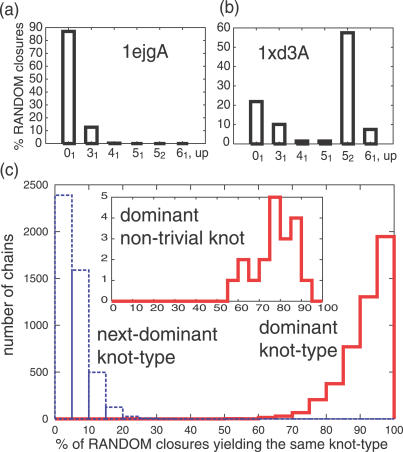
Dominance of Knot Types in the RANDOM Knot Closure(A) Percentage of the 1,000 RANDOM chain closures yielding the various knot types for the protein chain with ID 1ejgA and length N = 46. In this chain, the trivial knot or unknot (01) dominates, while the trefoil knot (31) is the next-dominant knot type. Both CENTER and DIRECT methods also predict a trivial knot.(B) Percentage of the 1,000 RANDOM chain closures yielding the various knot types for the protein chain with ID 1xd3A and length N = 229. In this chain, the knot 52 dominates, while the trivial knot is the next-dominant knot type. The CENTER method also predicts a 52 knot, while the DIRECT method detects a trivial knot.(C) Histogram of the percentage of RANDOM chain closures giving the dominant (solid steps) and next-dominant (dashed boxes) knot types within a single chain for all 4,716 protein chains. The inset shows the histogram for the percentage of closures giving the dominant knot type that is not a trivial knot.